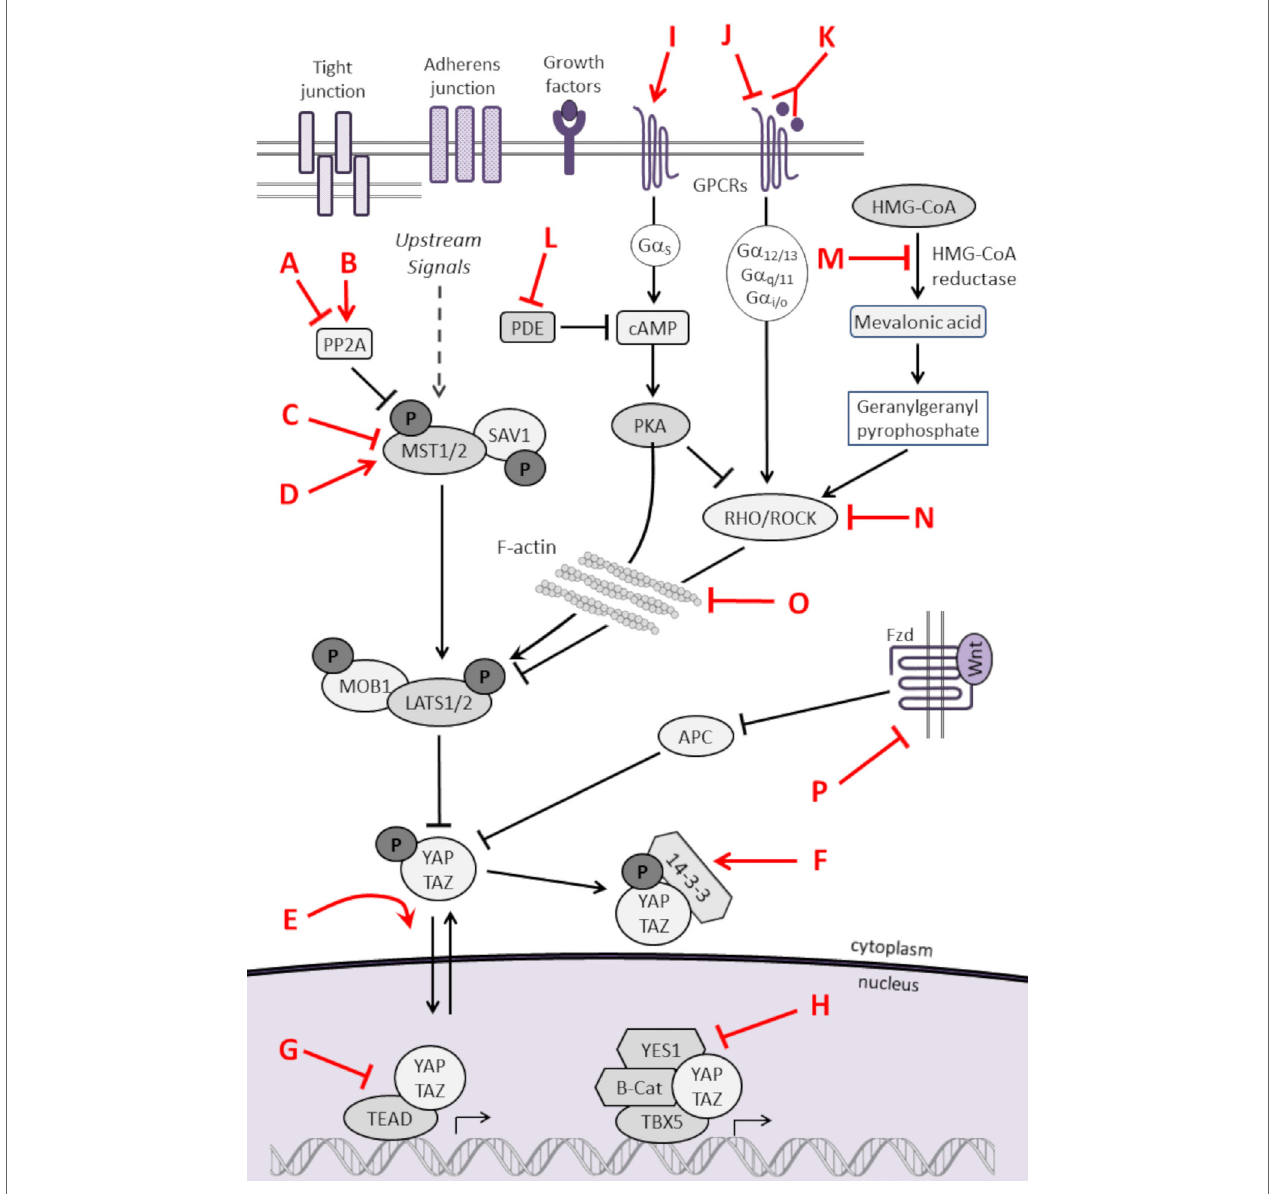
concomitant changes in YAP or TAZ activity, these provide proof of principal that targeting Hippo signaling could be harnessed as a novel strategy to treat sarcomas. This is not an inclusive list, and other compounds are known to modulate Hippo components. Figure is modified with permission from Park et al. (202). Letters in Red correspond to the letters in the Key in Table 3